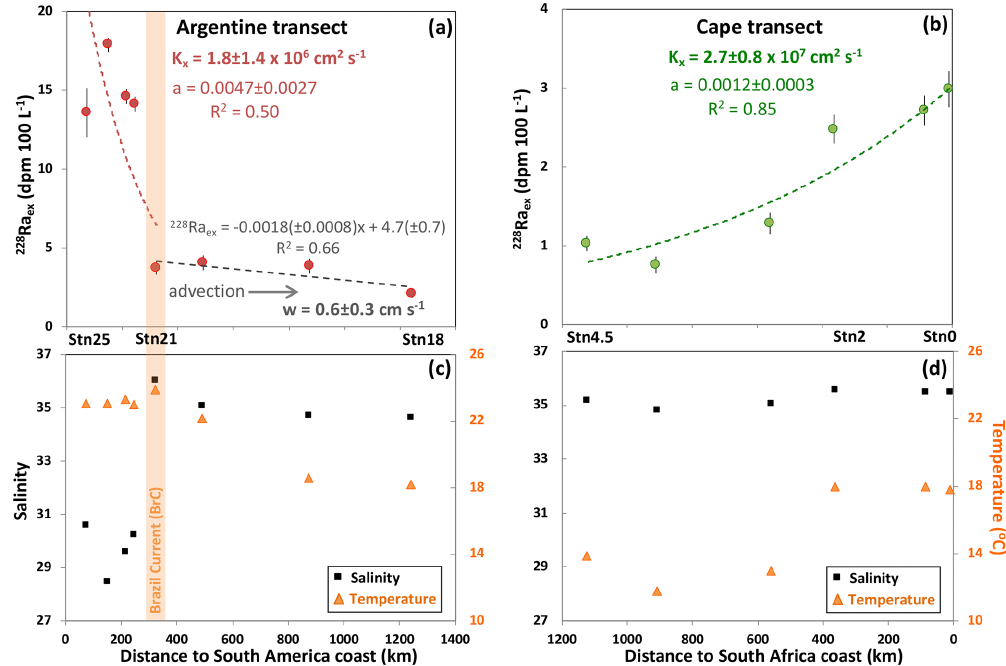
Figure 5. Plots of 228 Ra ex in the surface ocean ( < 10m) along the (a) Argentine and (b) Cape Basin 40 ◦ S Atlantic transects, with the distributions of salinity and temperature shown in panels (c) and (d) . The orange band indicates the boundary of the BrC in the Argentine Basin transect, highlighted by high salinity and temperature. The dashed red and green lines show exponential regression trends through the 228 Ra ex data (Argentine Basin transect: only to BrC; Cape Basin transect: the whole transect). The gradients of the exponential fit (the a values) are used in Eq. (3) for the K x calculation. The errors of a and K x are ± 1SD. The dashed grey line shows a linear regression trend through the 228 Ra ex data from BrC to the open ocean in the Argentine Basin transect, which is used in Eq. (4) to estimate the advection water transport velocity ( w ). Table 2. 228 Ra-derived shelf–ocean dTE fluxes along the 40 ◦ S Atlantic transect ∗